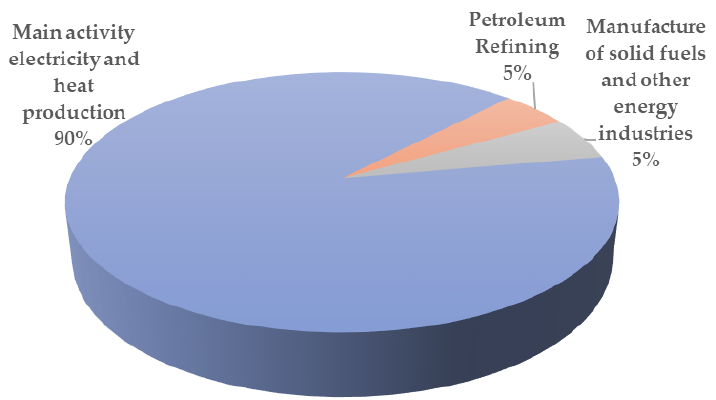
Figure 3. Pie chart of GHG emissions from the energy industries in terms of GHG sources in 2018 [18].